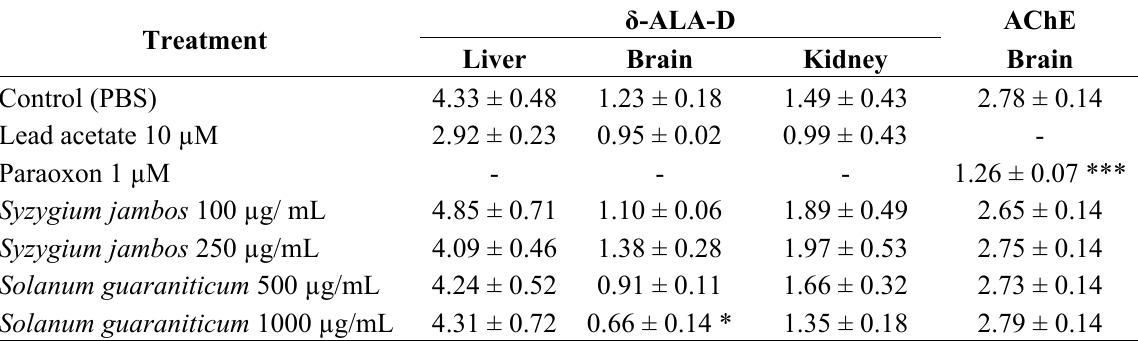
Table 2. Effect of extracts on tissue δ -ALA-D and AChE activity in rat